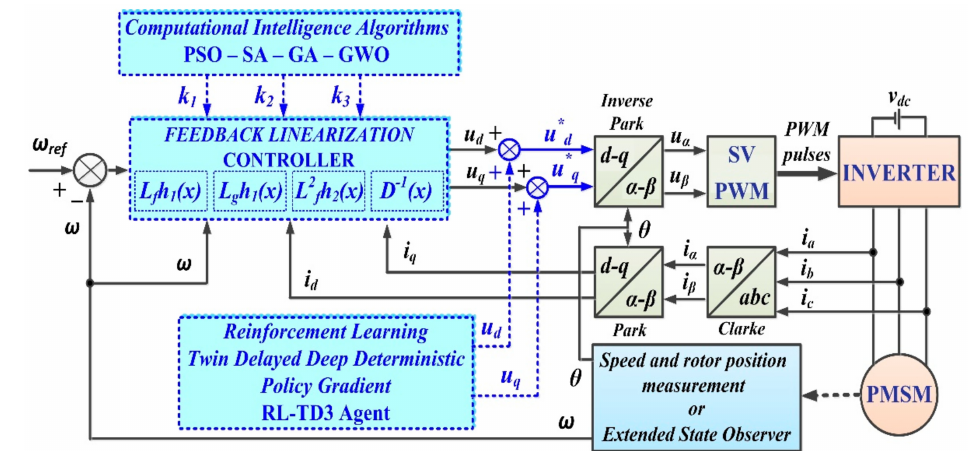
Figure 3. The proposed control block diagram of PMSM–CS–CI based on an FL-type